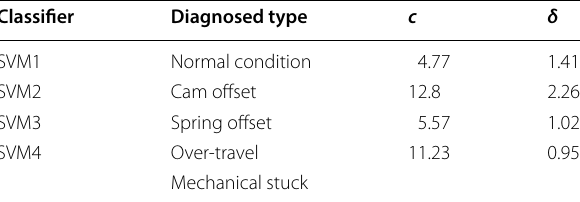
Table 1 Optimal parameters of each SVM classifier